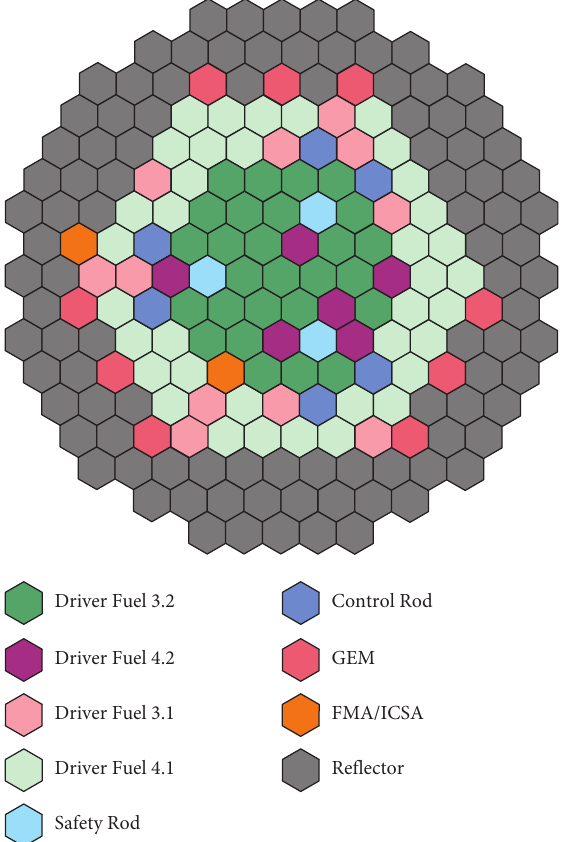
Figure 4: Loading pattern of the calculation model of FFTF in the radial direction.